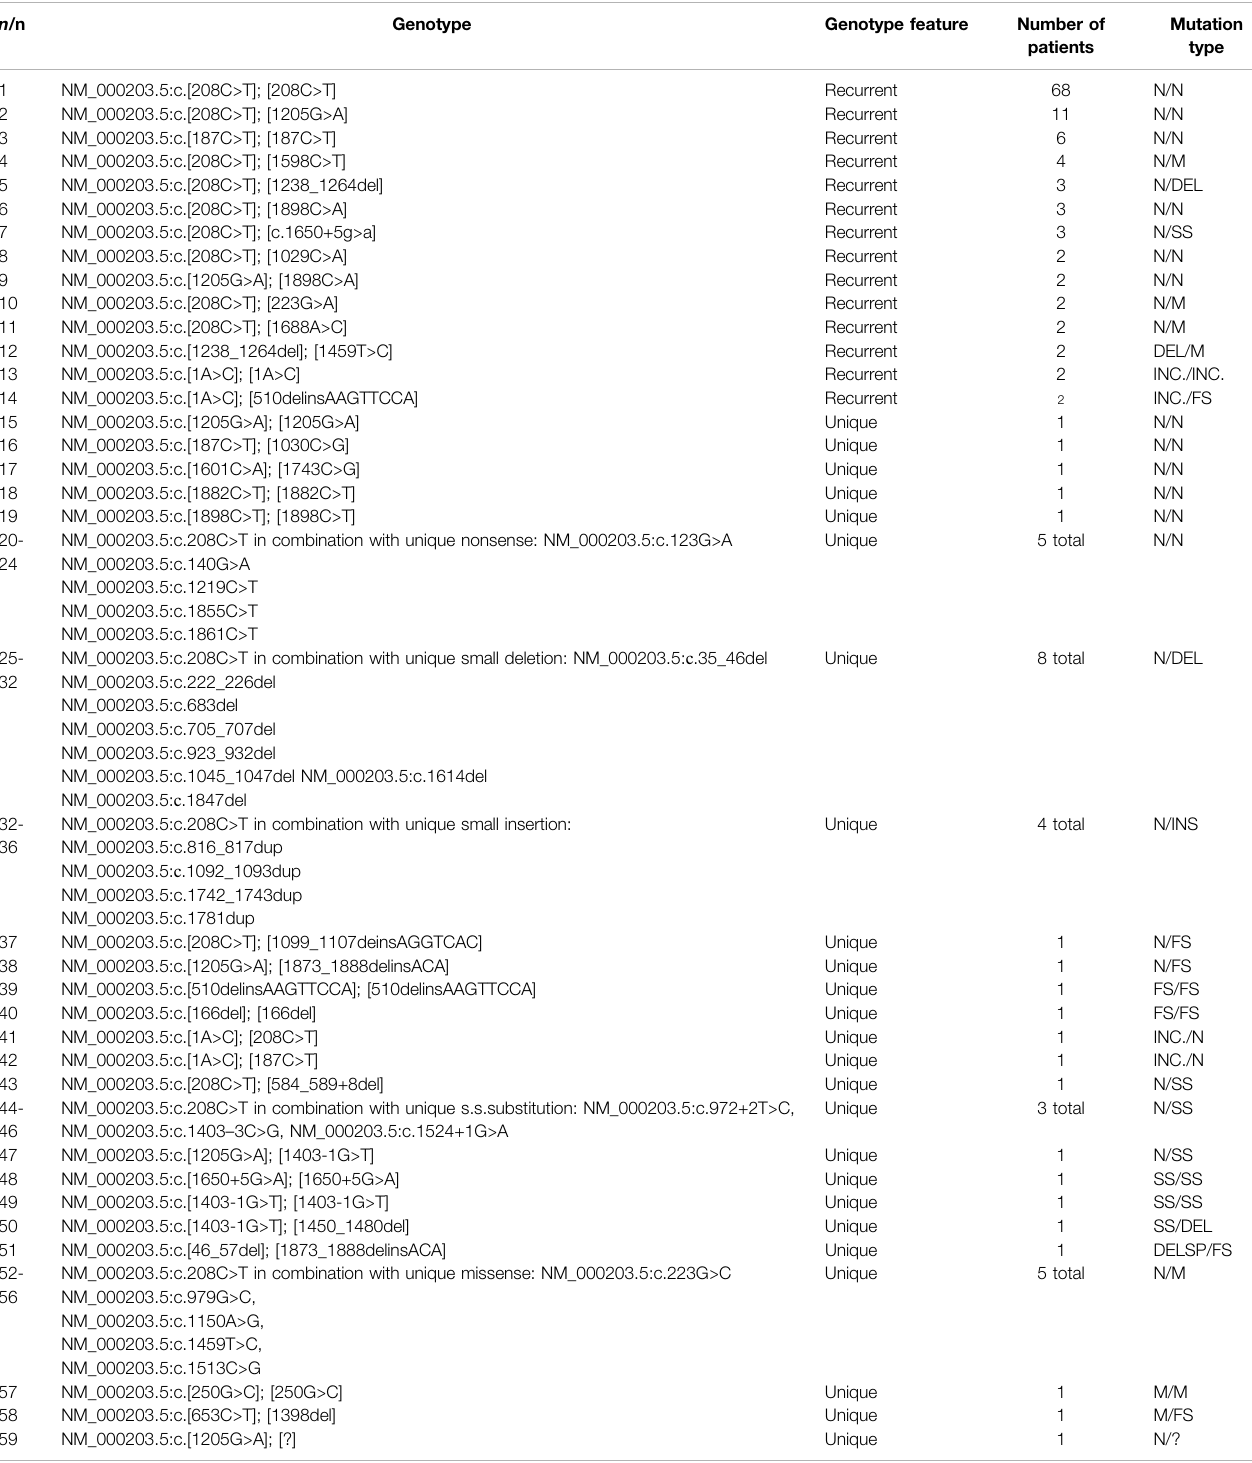
TABLE 4 | Patients with MPS I with a severe phenotype ( n (cid:1)